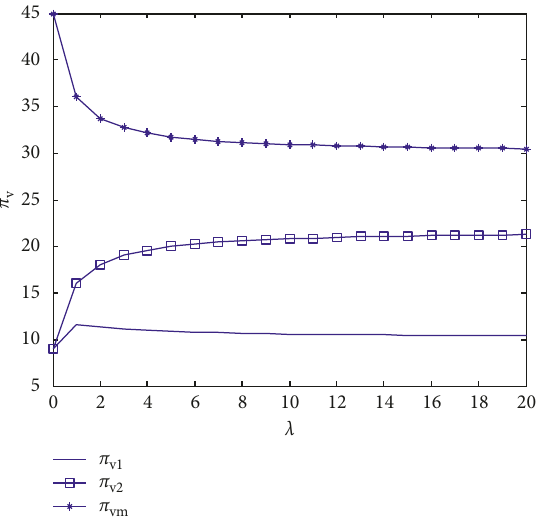
Figure 4: Impacts of vertical fairness concern on the profit of supply